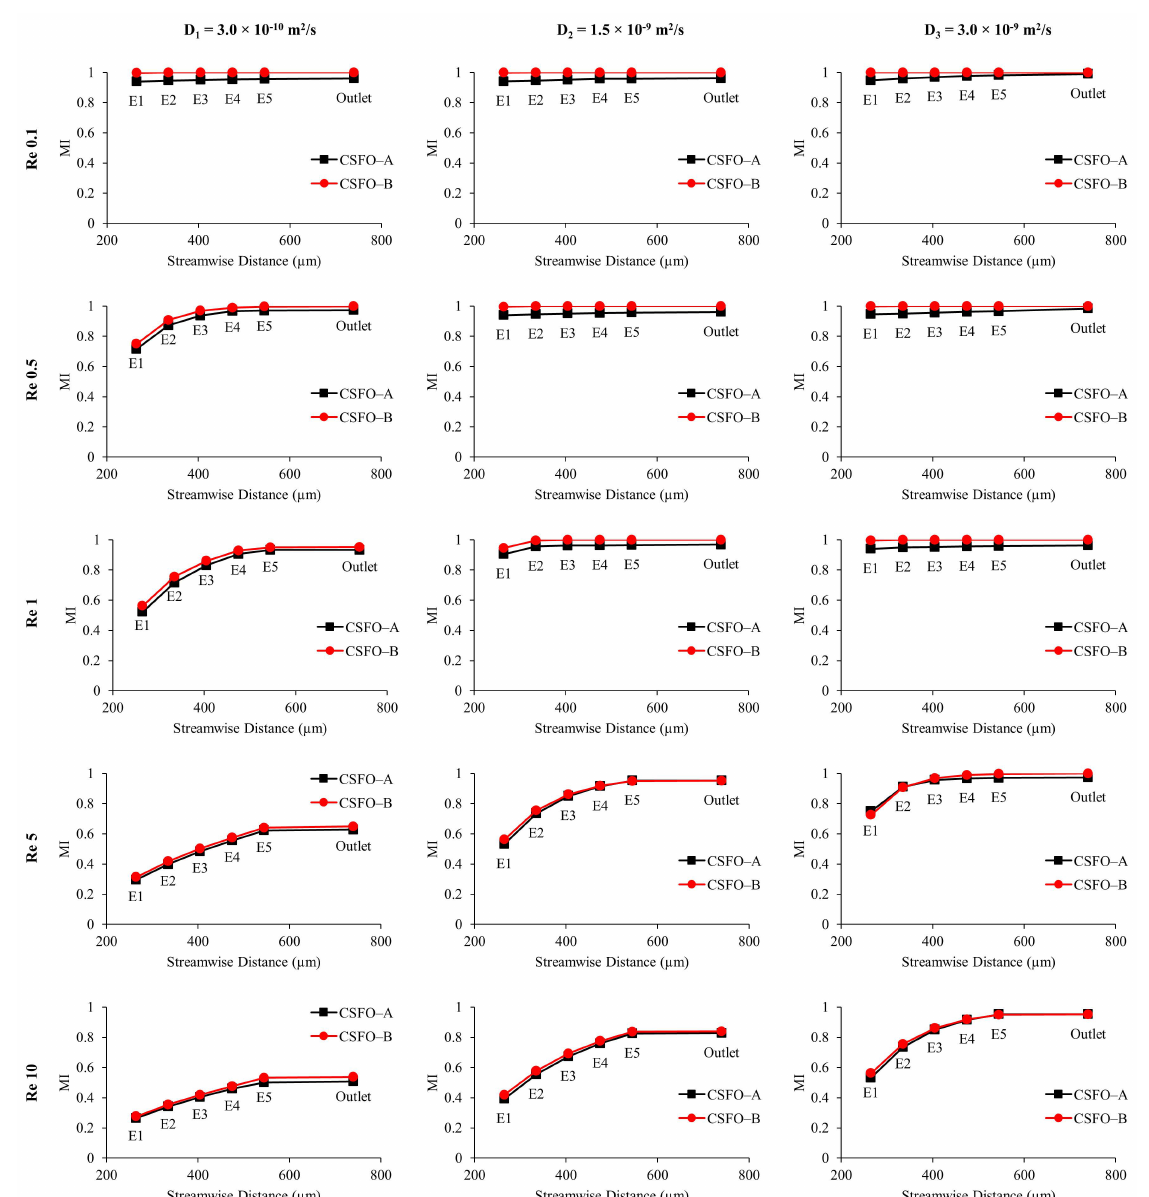
Figure A7. The development of MI along the CSFO–A and CSFO–B micromixer configurations for all flow conditions (i.e., Re = 0.1, 0.5, 1, 5, and 10) and molecular diffusion constants (D 1 , D 2 , and D 3 ). MI values are calculated on the E1, E2, E3, E4, and E5 cross-sections which are normal to the